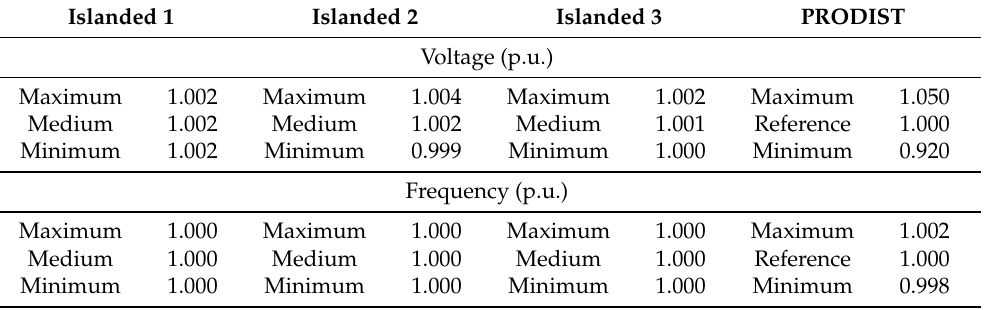
Table 7. BESS 1 quality of energy in comparison with